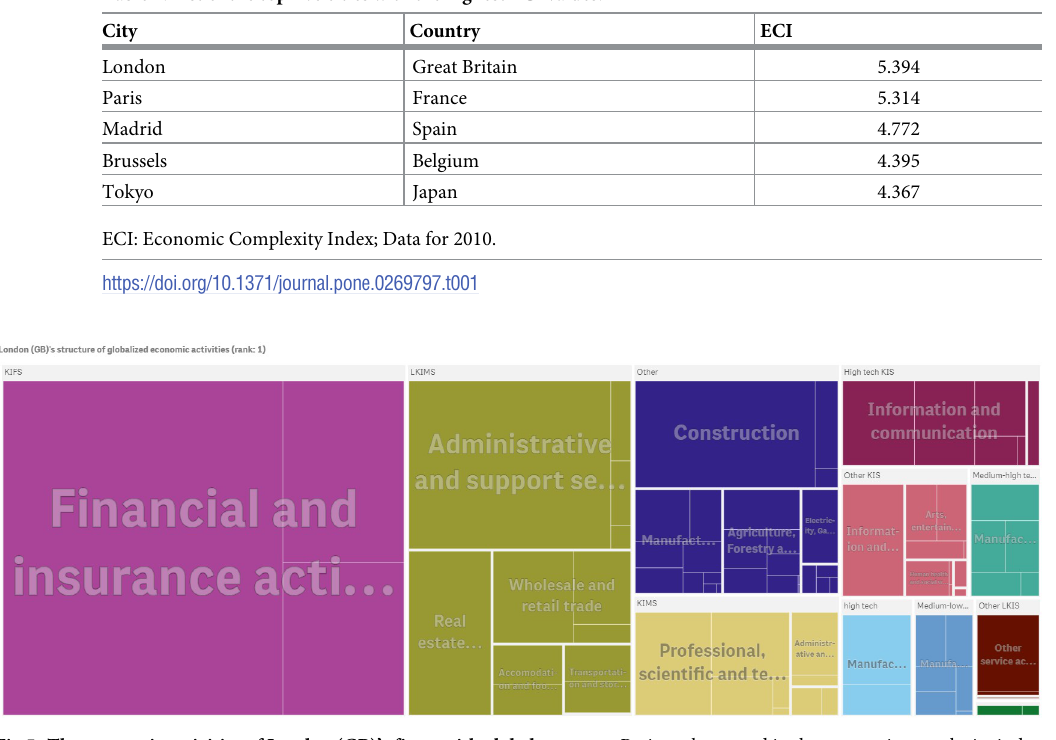
Fig 5. The economic activities of London (GB)’s firms with global presence. Paris ranks second in the economic complexity index of cities in 2010 (ECI: 5.394). The figure has been generated using Qlik Sense.